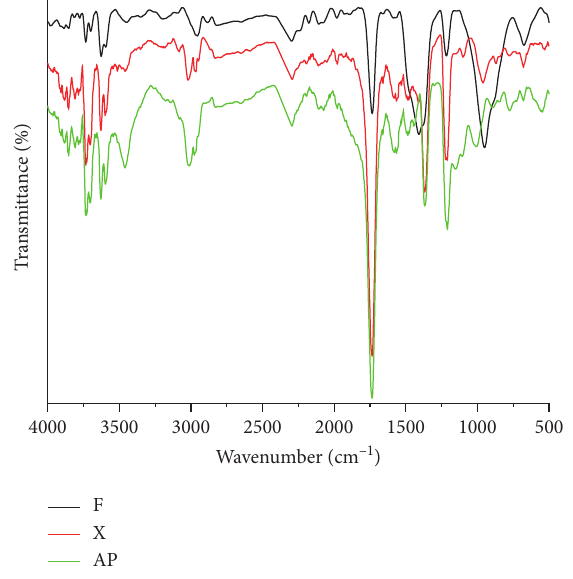
Figure 12: FT-IR image of 5 M and 1 :3 of SH: